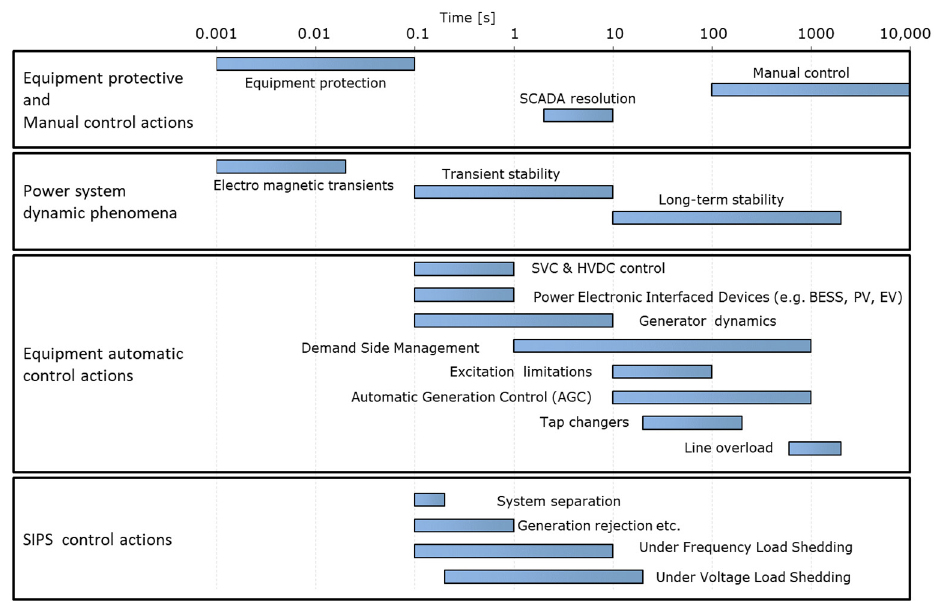
Figure 2. Time frame of power system-related phenomena, based on [21].